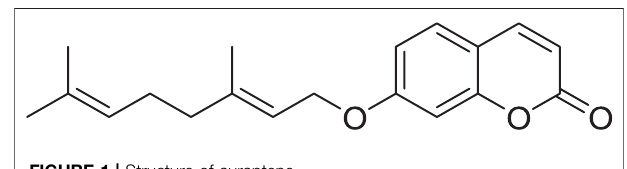
FIGURE 1 | Structure of auraptene.